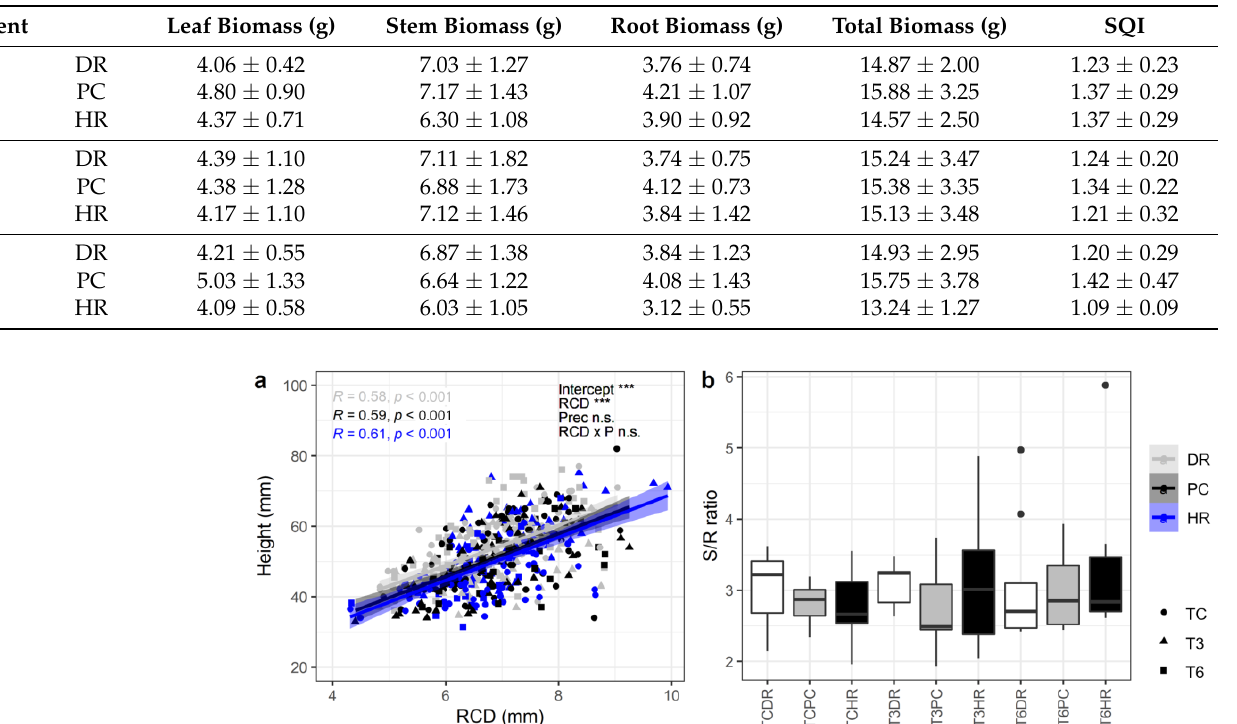
Table 2. Biomass and seedling quality index (SQI) of L. kaempferi (Lamb.) Carr. seedlings under extreme climate events regarding temperature and precipitation. TC: ambient temperature, T3: warming by 3 ◦ C, T6: warming by 6 ◦ C, DR: drought, PC: ambient precipitation, HR: heavy rainfall. Values are means ± S.D. ( n = 9). There was no significant difference in the variables between treatments at 5% levels using a Tukey HSD test.